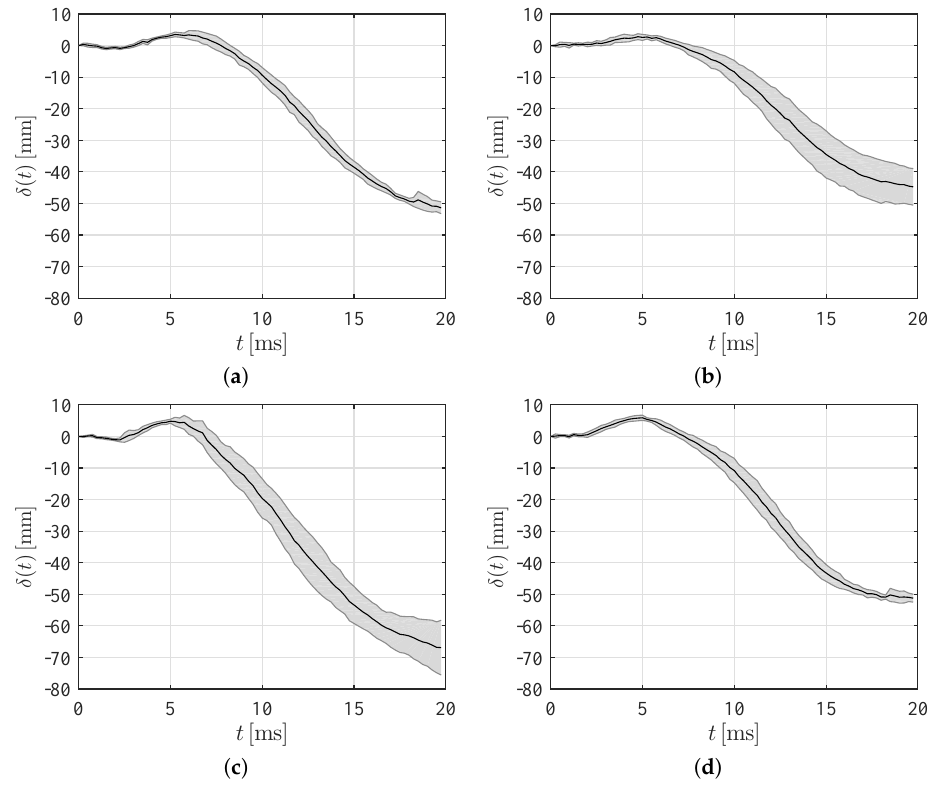
Figure 4. Time traces of the mean value of the tip deflection for ( a ) Light-Short; ( b ) Heavy-Short; ( c ) Light-High; and ( d ) Heavy-High conditions. The shaded area represents one standard deviation across